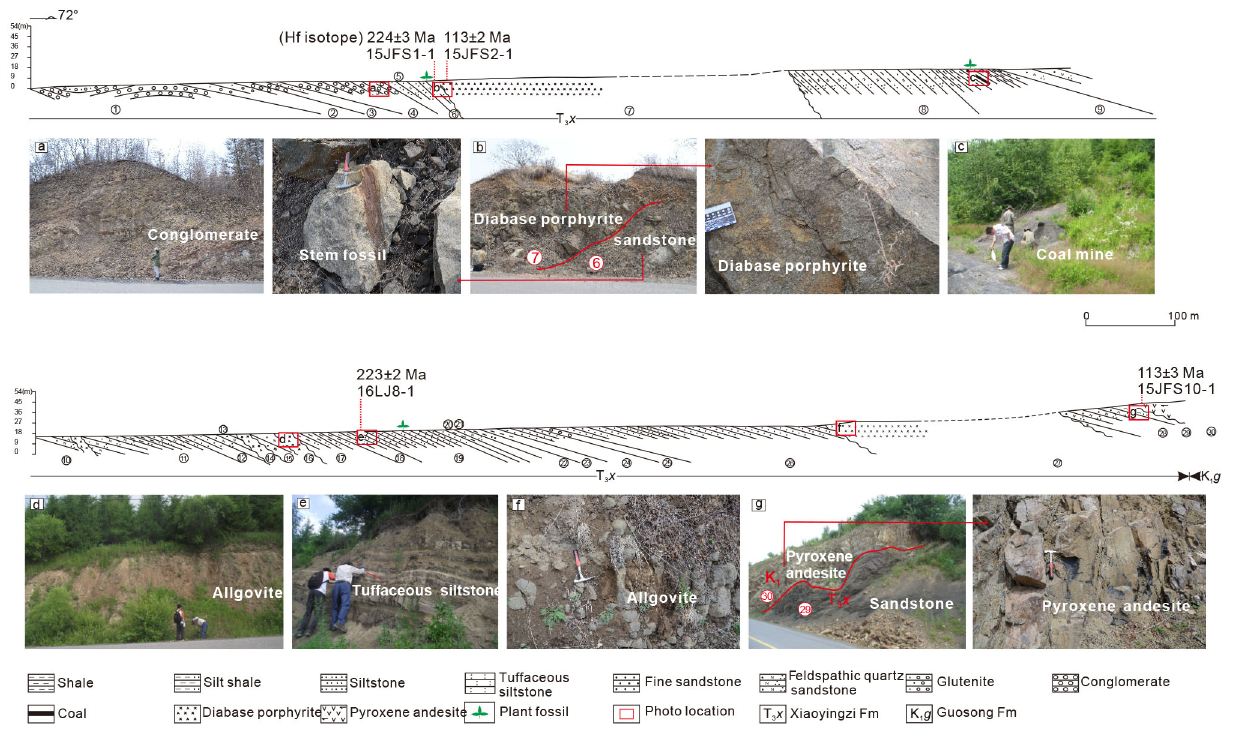
Figure 5. Stratotype outcrop of the Xiaoyingzi Formation and sampling locations. The location of the stratotype is indicated by the dotted line in Fig. 2 (Sect. 1). The numbers in circles indicate the sequence of beds in the section. The ages refer to the youngest zircon age populations of samples. The dotted line represents vegetation